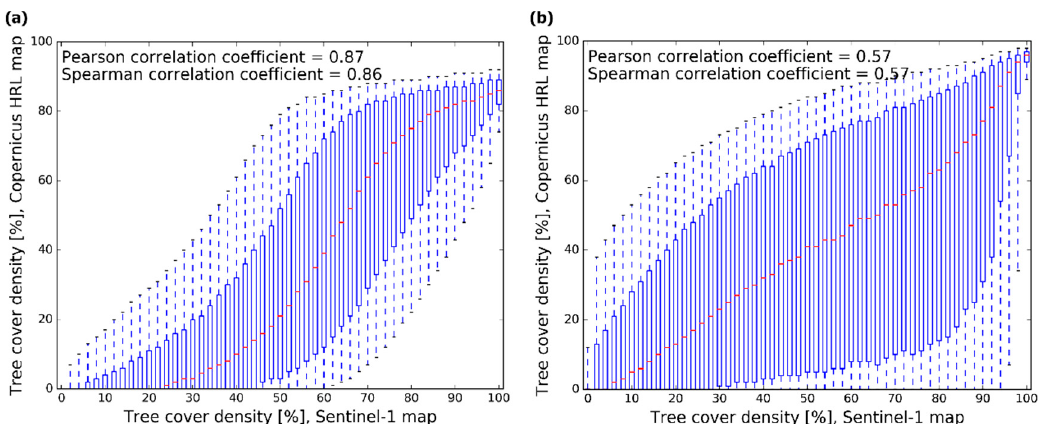
Figure 15. Plots showing the distribution of the tree cover density (TCD) values over ( a ) Czech Republic and ( b ) Sicily. Red lines indicate the average TCD value, blue boxes indicate the interquartile range of the TCD values (25th to 75th percentiles), dashed lines indicate the 10th and 90th percentile of the TCD values.